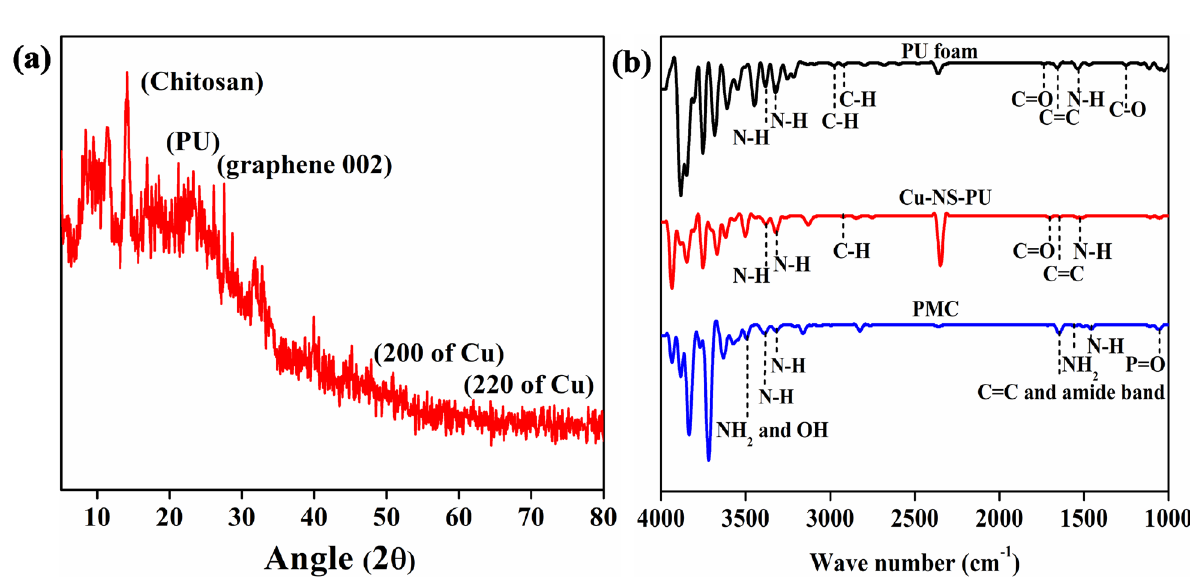
Figure 4. XRD analysis and FT-IR Spectra of the PMC material. ( a ) XRD analysis, ( b ) FT-IR